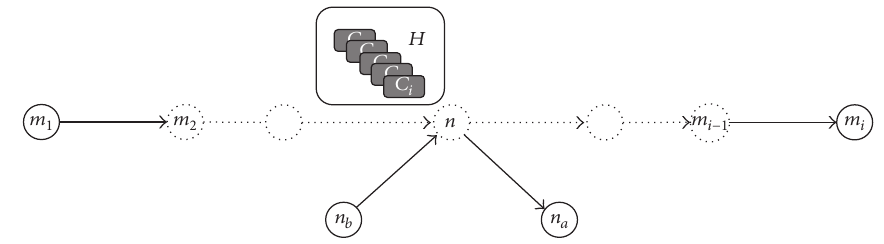
Figure 4: Scheme of the elements that characterize a system where modal shift takes place.